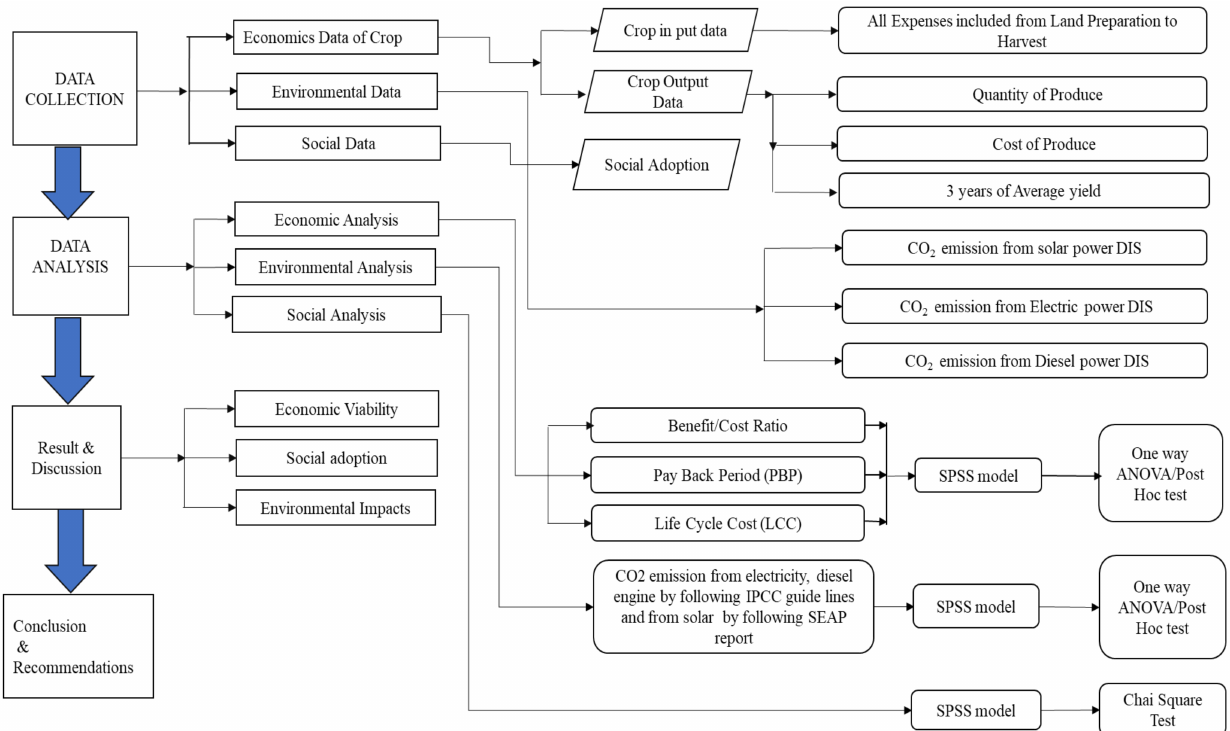
Figure 3. Overall methodological